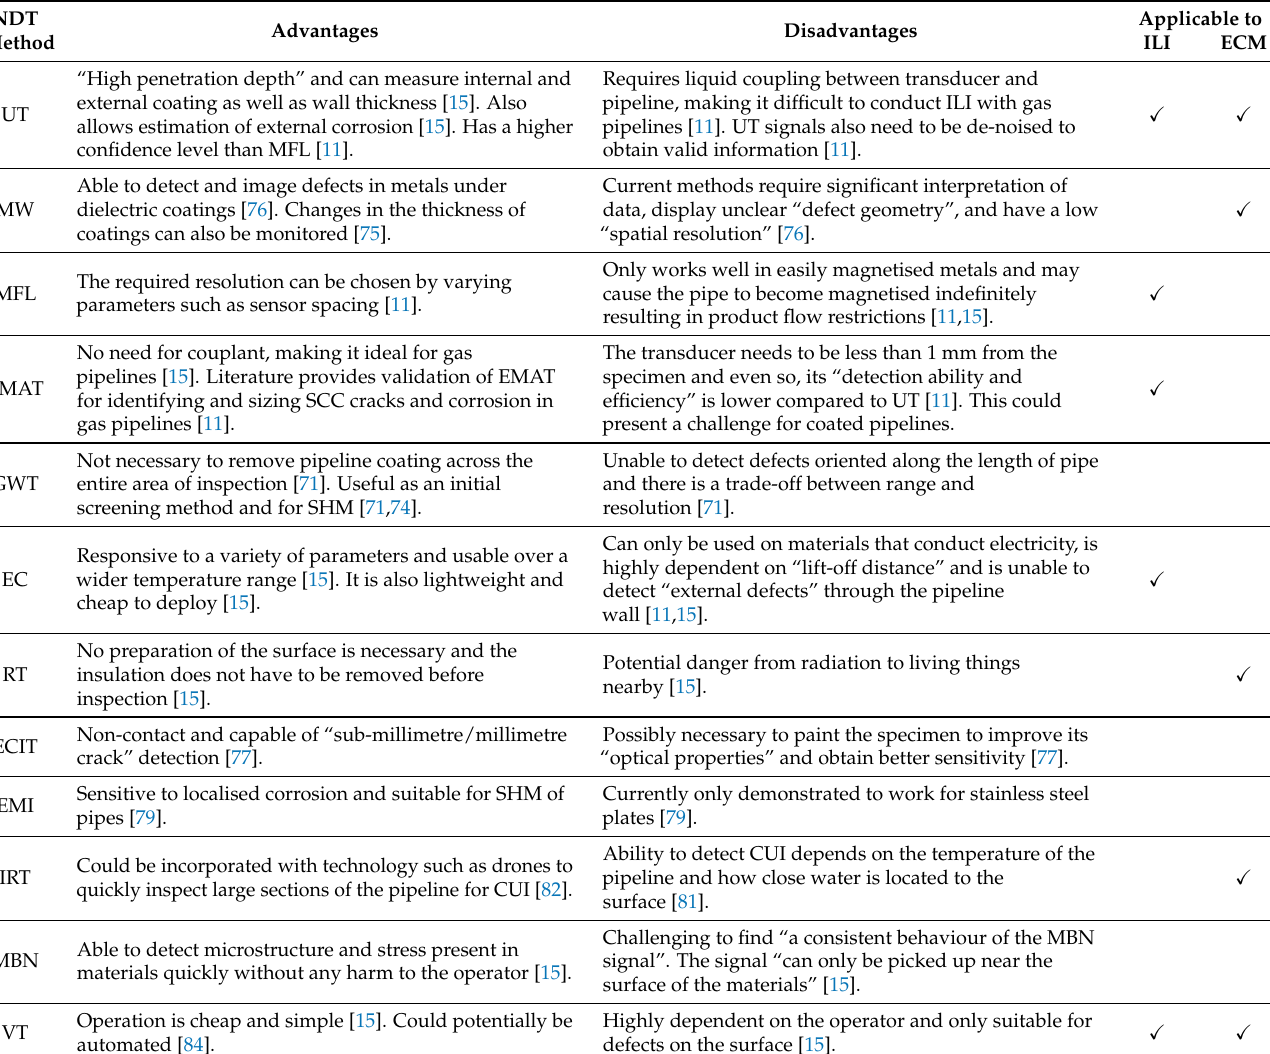
Table 6. NDT methods and a comparison of their advantages and disadvantages in the context of coated